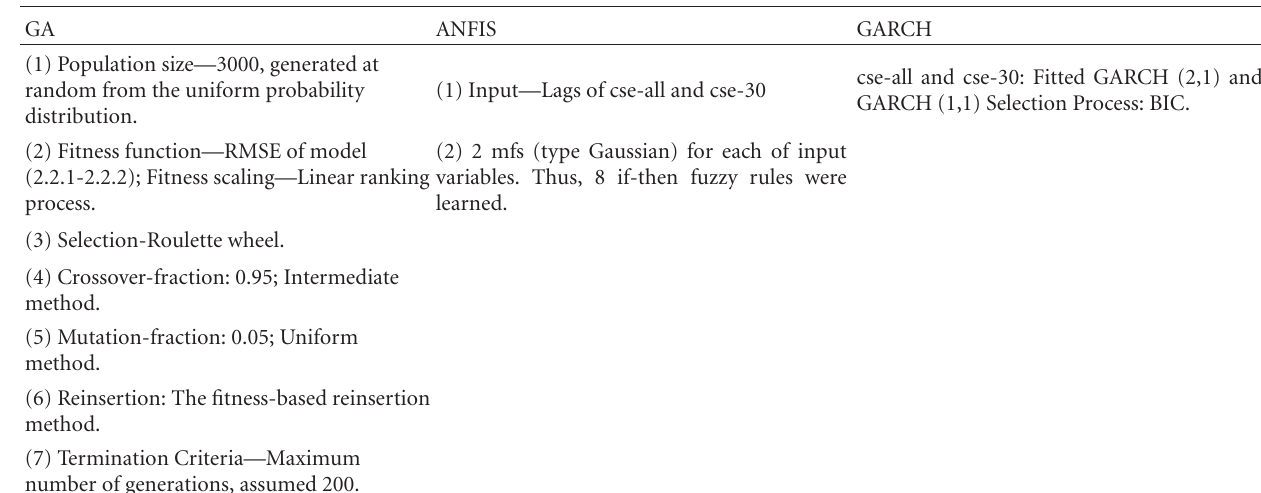
Table 7: Computational settings for selected forecasting models.